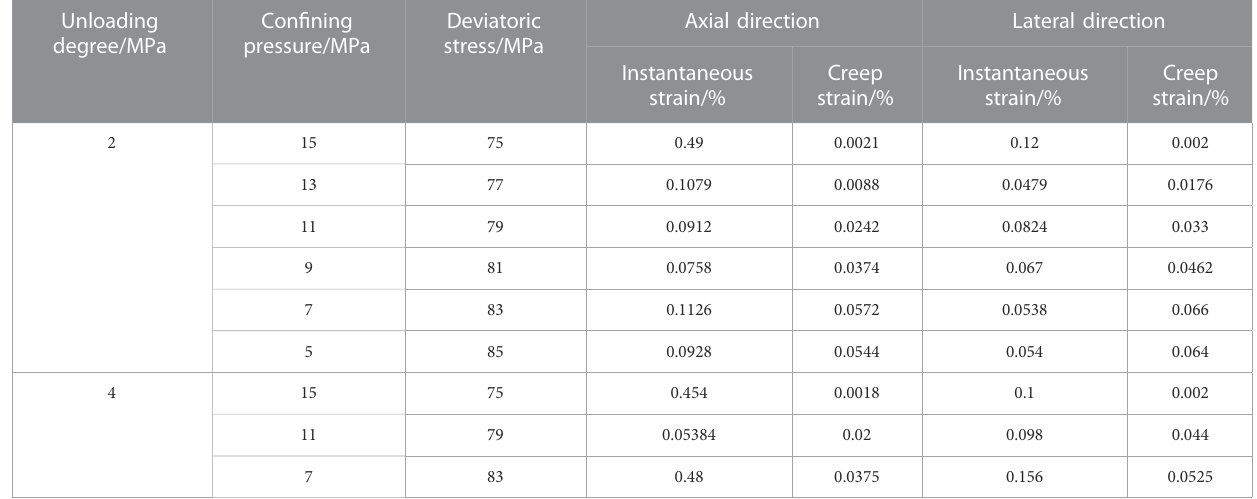
TABLE 2 Unloading creep characteristic indexes of Flint limestone under different unloading amounts. Unloading